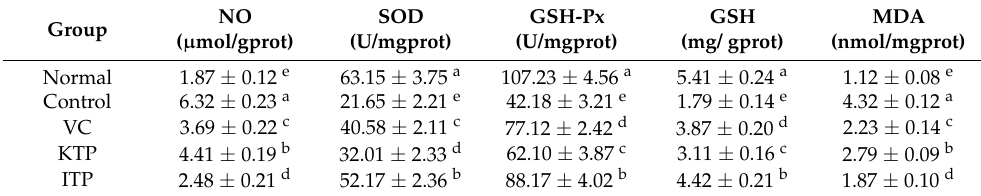
Table 4. Activities of NO, SOD, GSH-Px, GSH and MDA in spleen of